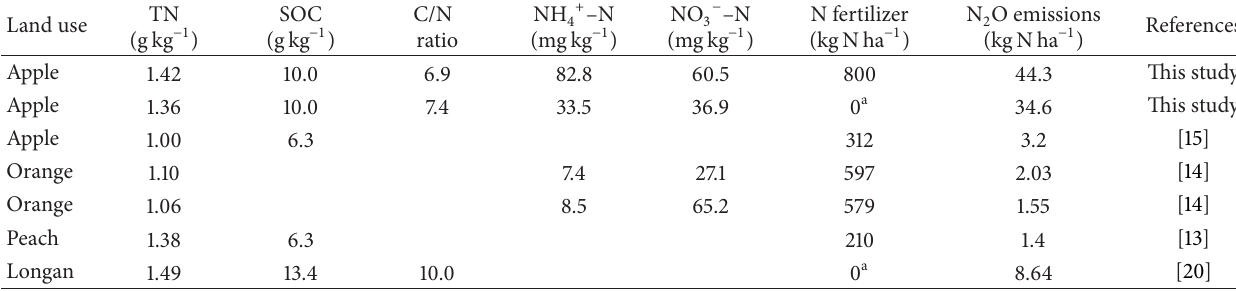
O emissions from orchard 2